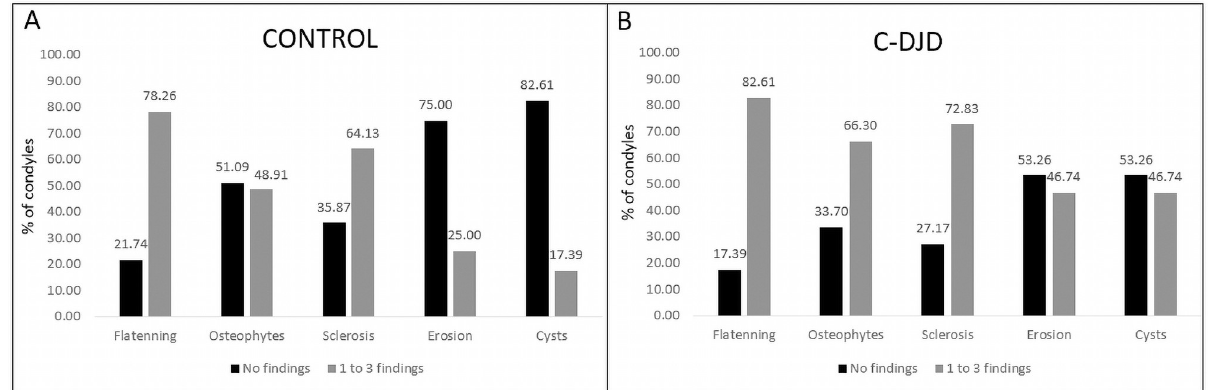
Fig 2. Percentage of condyles with no radiographic findings (score 0, not visualized) compared to condyles with radiographic findings (scores 1–3 of severity grouped).